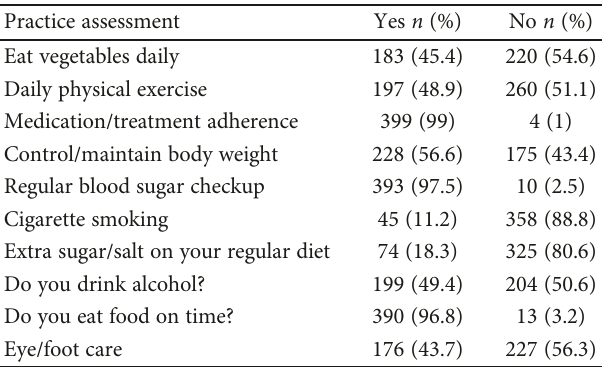
Table 4: Practice assessments towards glycemic controls among DM patients at the University of Gondar referral hospital